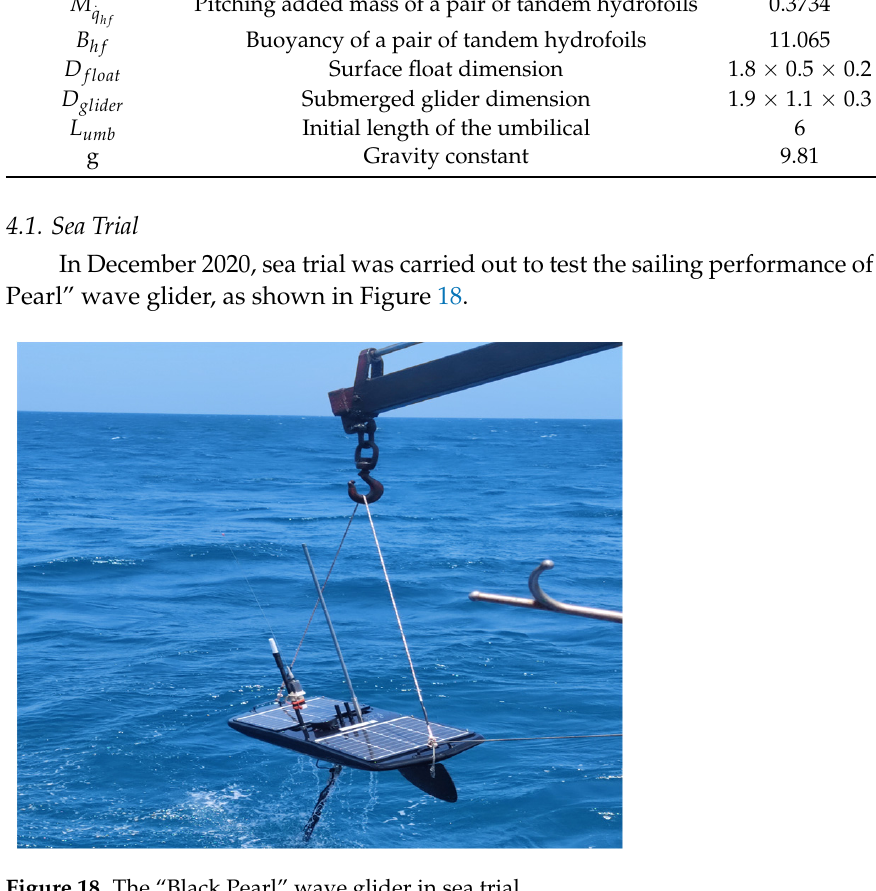
Figure 18. The “Black Pearl” wave glider in sea trial. Considering the degrees of freedom in the dynamic model, a desired straight-line path between point T1 and point T2 was set. The positions and the velocities of the “Black Pearl” wave glider can be obtained by using a GPS. Figure 19 gives the actual sailing trajectory of the wave glider represented by the blue solid line and the red box is the straight-line path in sea trial. And the red box includes the section of sensor data. In this work, these → T 2 T 1 path because the difference between the desired course and the data were obtained in wave direction was relatively stable in this path. The sailing distance from T2 to T1 is about 5.5 km, and the sailing time is about 3